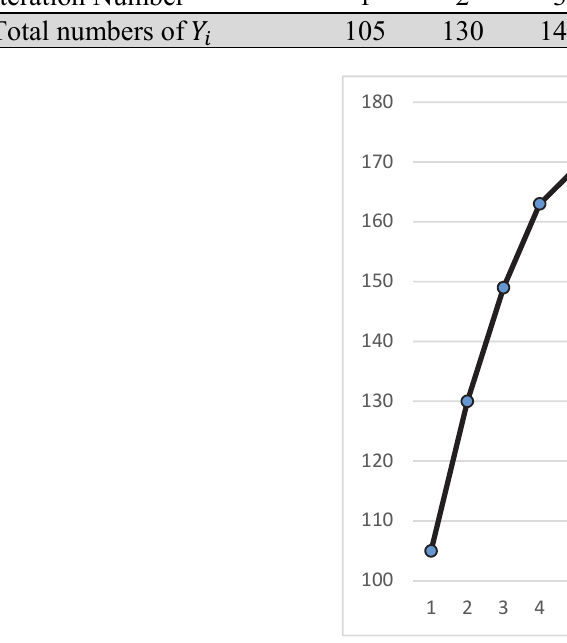
Total numbers of Y